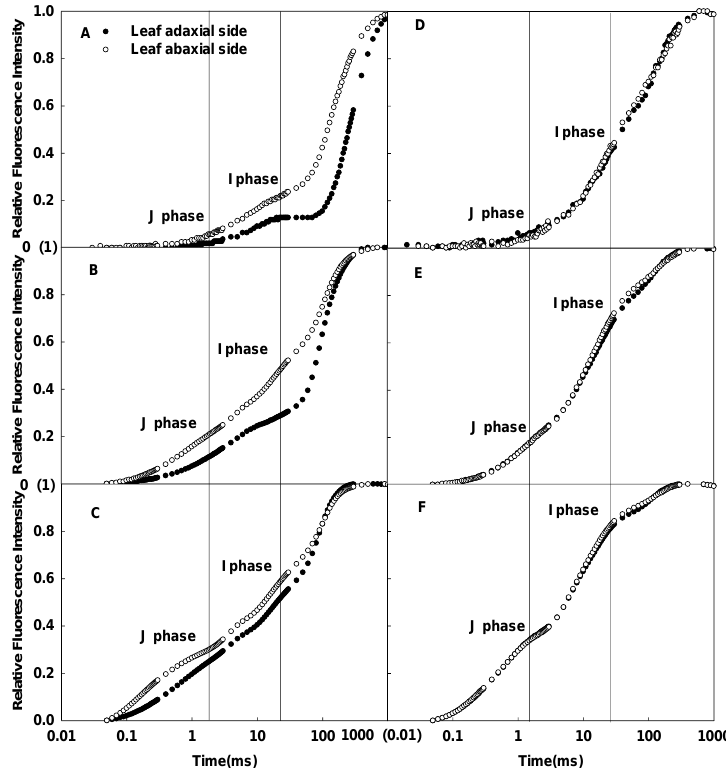
Figure 1. Differences in the CFI curves of the adaxial and abaxial sides of sunflower ( A – C ) and sorghum ( D – F ) leaves under various pulsed light intensities. The CFI curves are presented as mean values of the relative variable fluorescence (Vt). The pulsed light intensities were 200 ( A , D ), 1000 ( B , E ), and 3000 ( C , F ) µmol·m −2 ·s −1 .